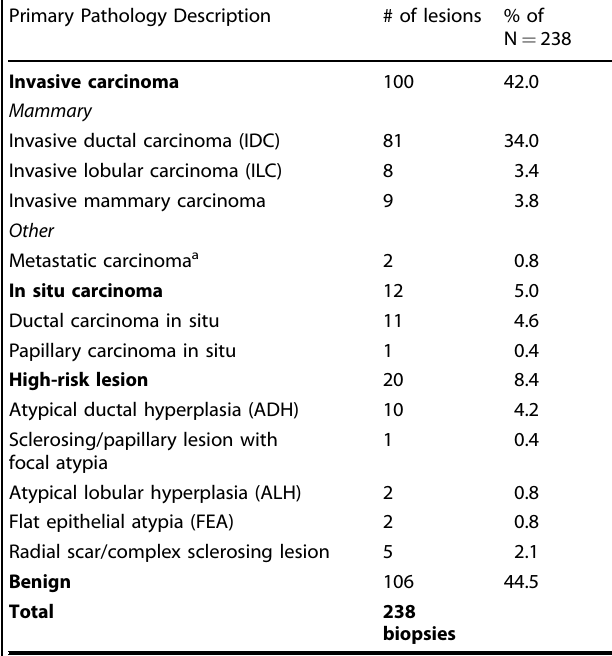
Table 1. Primary pathology for lesions biopsied for research among patients consented to the breast biopsy